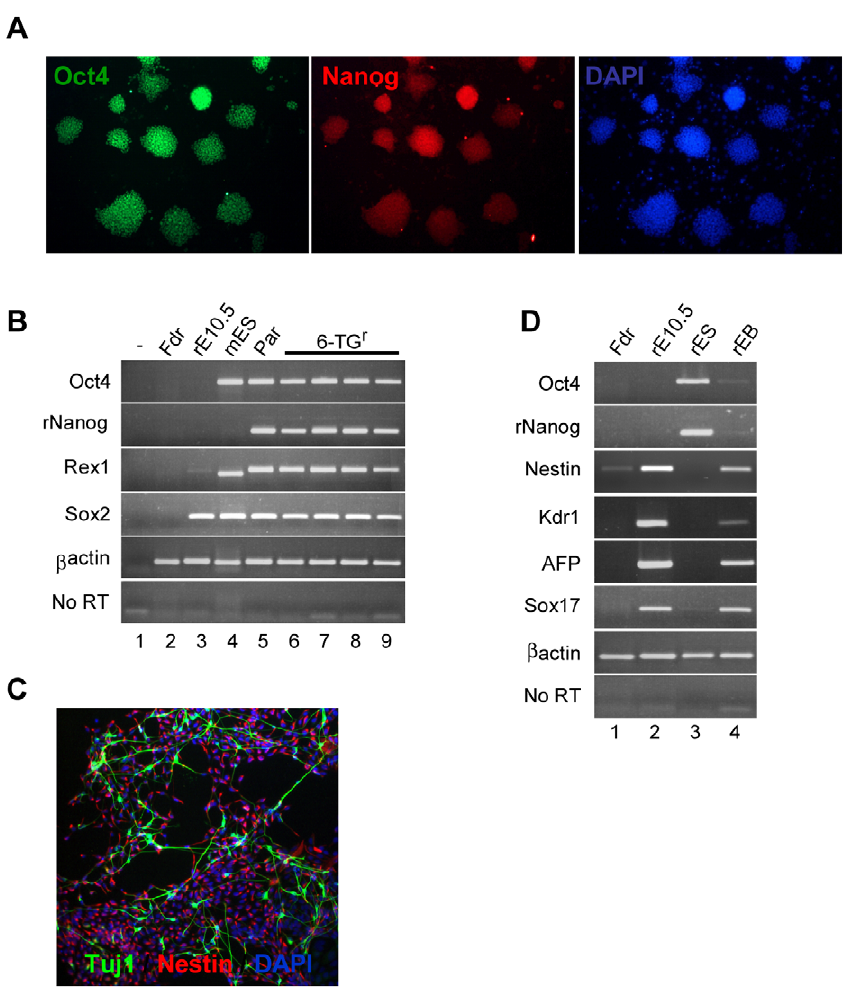
Figure 2. Characterisation of hprt -targeted rat F344 embryonic stem cells. (A) Immunohistochemical staining of targeted clone 1-B9 for Oct4 and Nanog (Magnification x100). (B) RT-PCR analysis of (1) Water blank, (2) DIA-M feeder layer, (3) rat E10.5 embryo, (4) E14Tg2a mouse ES cells, (5) RIF5.2 parental rat ES cell line, (6) 6-TG-resistant clone 1-B9, (7) 6-TG-resistant clone 2 F10, (8) 6-TG-resistant clone 3-B4 and (9) 6-TG-resistant clone 3-C10. (C) Immunostaining for Nestin and Tuj1 following 11 day monolayer differentiation protocol of 6-TG-resistant clone 1-B9 (Magnification x100). (D) RT-PCR analysis of (1) DIA-M feeder layer, (2) rat E10.5 embryo, (3) 6-TG-resistant clone 1-B9, (4) Embryoid bodies formed from clone 1-B9. doi:10.1371/journal.pone.0014225.g002 PLoS ONE |